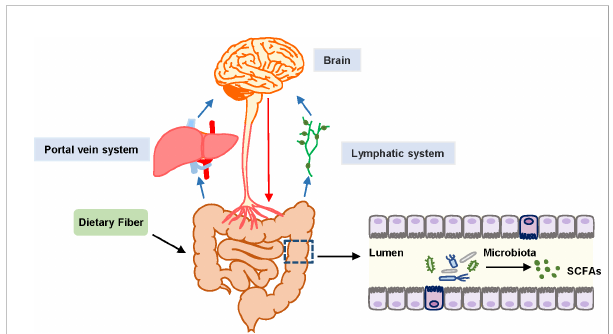
FIGURE 1 Schematic diagram of gut-microbiota-brain axis. Black arrows represent SCFAs that are the end products of fermentation of dietary fi bers metabolized by the gut microbiome. Blue arrows represent the transport of SCFAs from the gut to distant organs through the portal vein or to the thoracic duct and subsequently to the blood through the mesenteric lymph nodes, and ultimately transfer to the blood. Red arrows represent the association between the enteric nervous system (ENS) and CNS, contributing to the regulation of brain